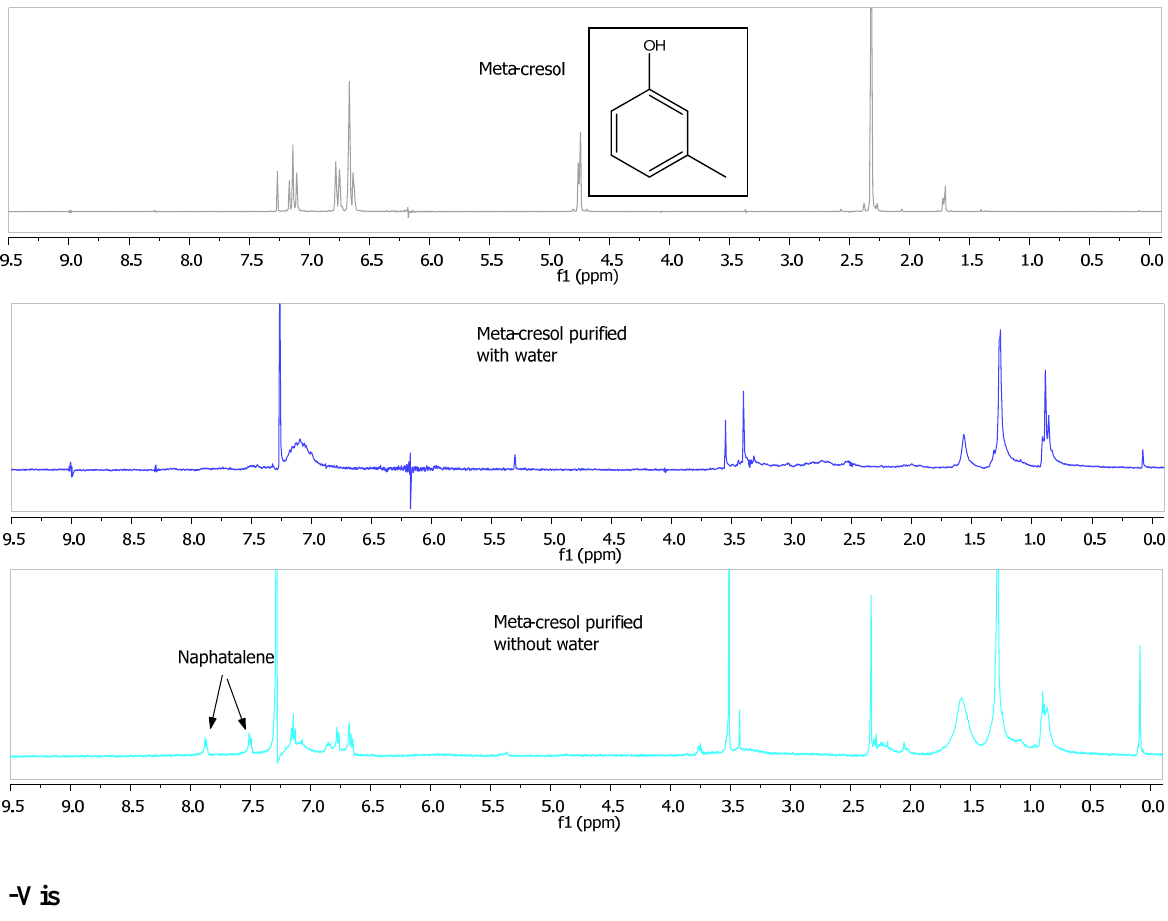
Figure S1. NMR-spectra of meta-cresol and the two different way of purification with and without water.